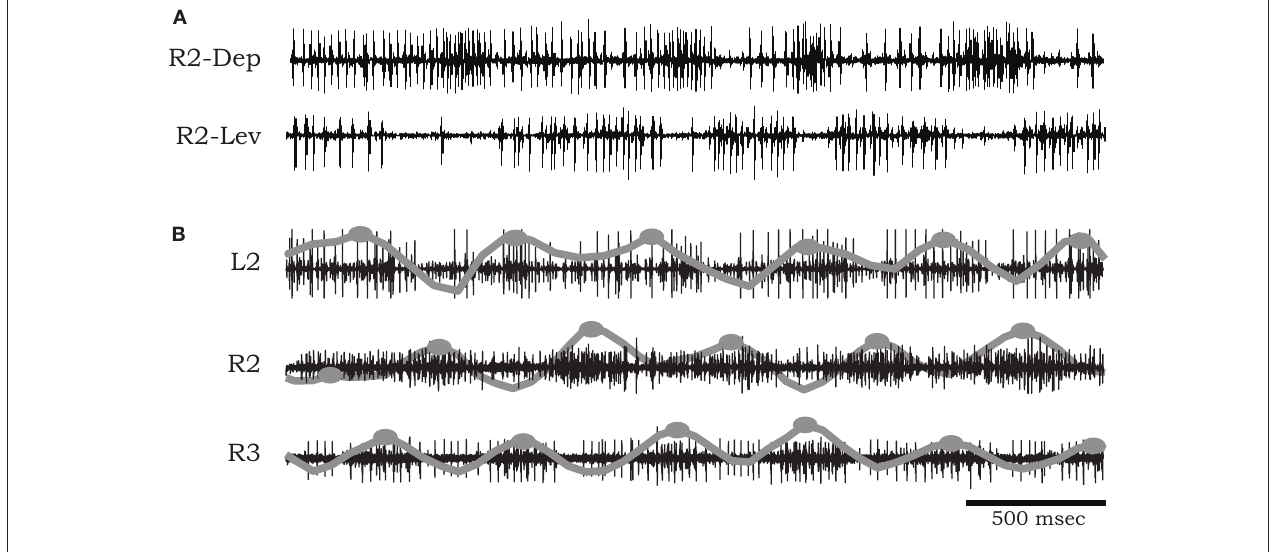
Figure 1 | (A) Simultaneous extracellular recordings showing alternation of burst activity in antagonistic coxal depressor and levator motoneurons of the mesothoracic ganglia of a cockroach after application of pilocarpine. (B) Simultaneous recordings from coxal depressor MNs in R2, L2, and R3 in the presence of pilocarpine. Raw data are overlaid by local spike densities (gray lines) and burst centers used for phase difference analysis are marked by gray